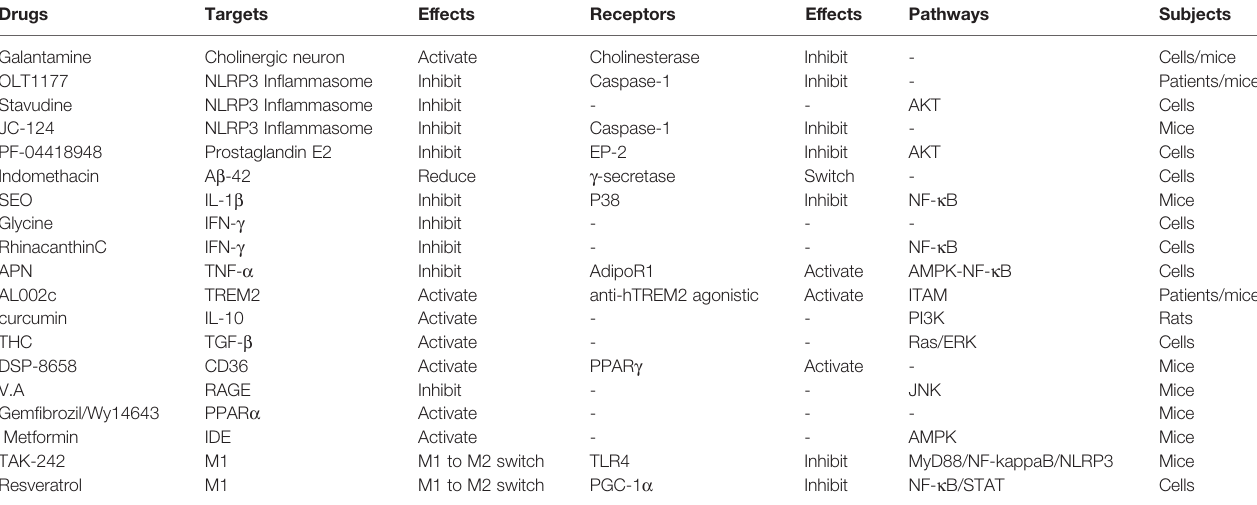
TABLE 1 | Diverse drugs, their effects and associated signal pathways.